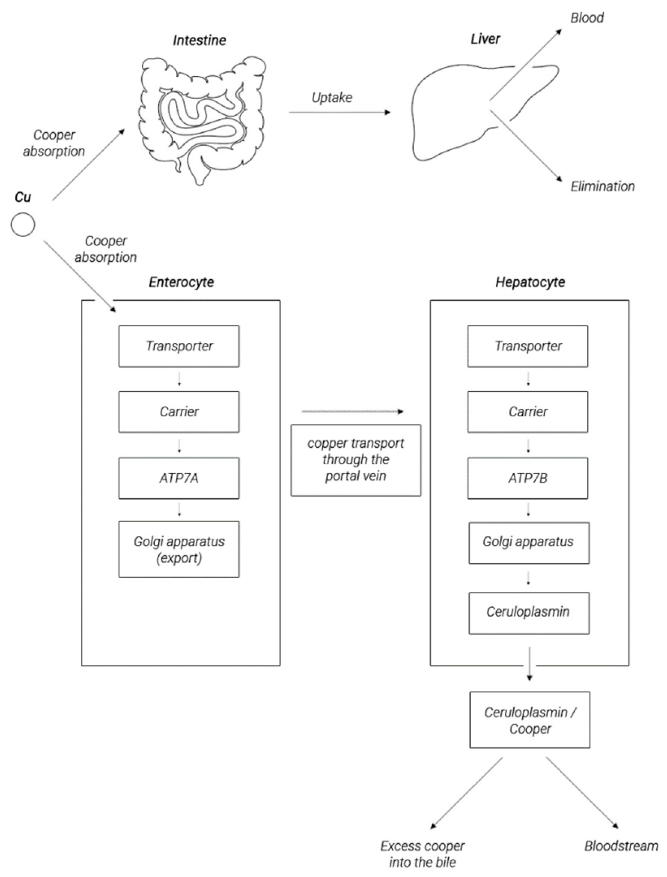
Figure 2. Copper metabolism in the human body (according to [51], modified). Table 1. Average concentration of copper in human organs (according to [13]).